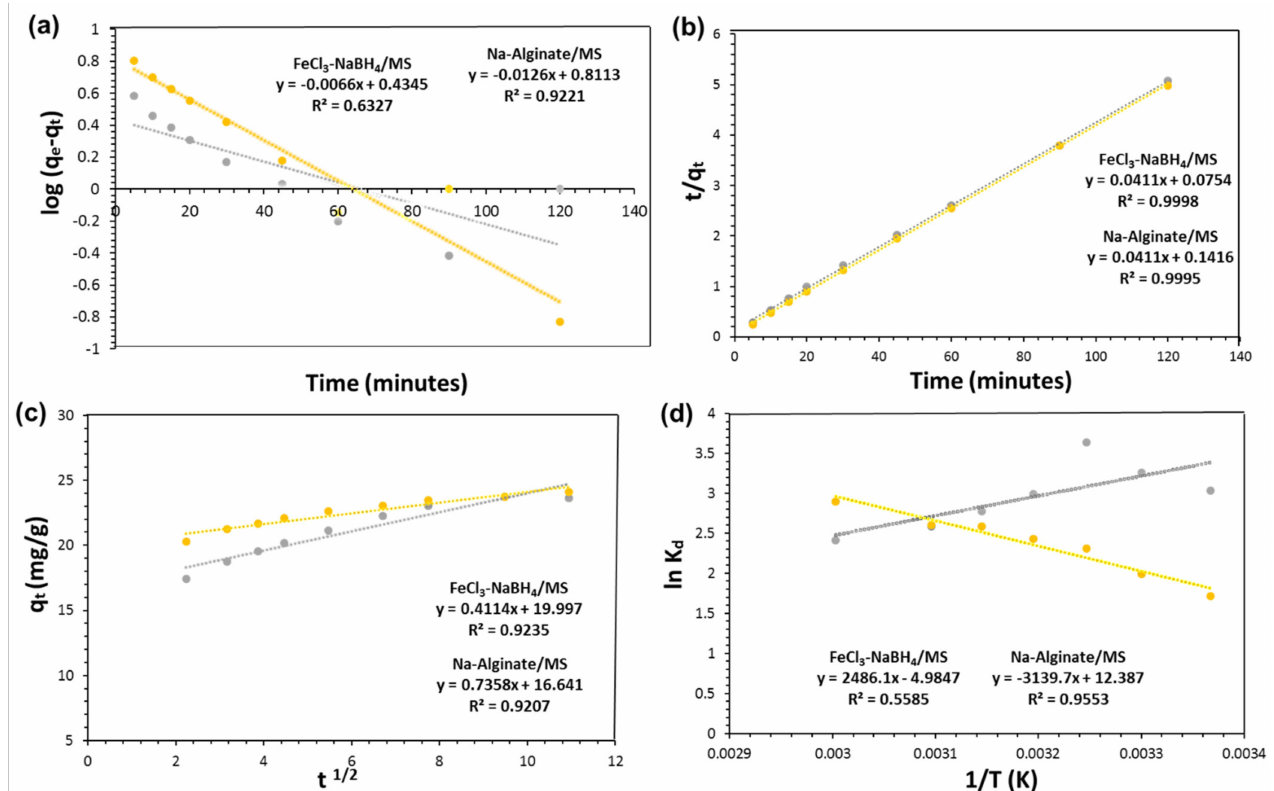
Figure 4. Kinetic plots for 2,4,6-TCP adsorption ( a ) Pseudo 1st order, ( b ) Pseudo 2nd order, ( c ) Intraparticle diffusion, and ( d ) adsorption thermodynamics of 2,4,6-TCP above FeCl 3 -NaBH 4 /MS and Na-Alginate/MS